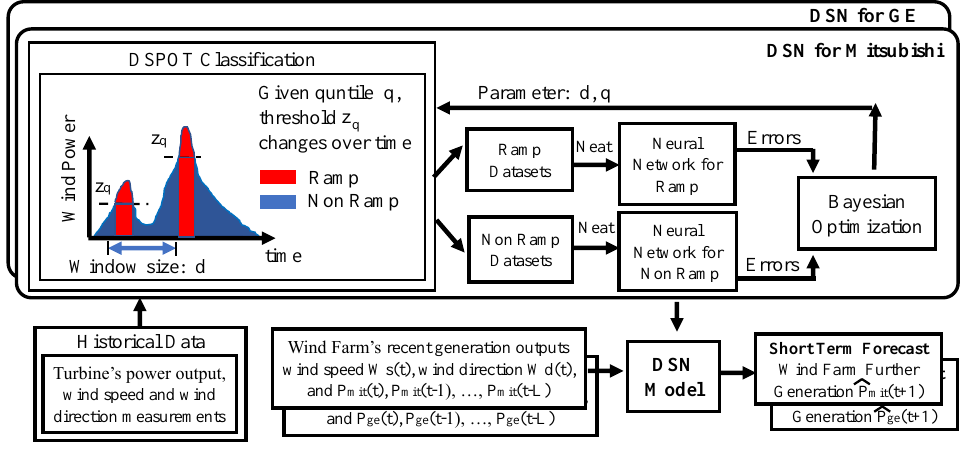
Figure 1. Illustration of the DSPOT-enhanced self-evolving neural